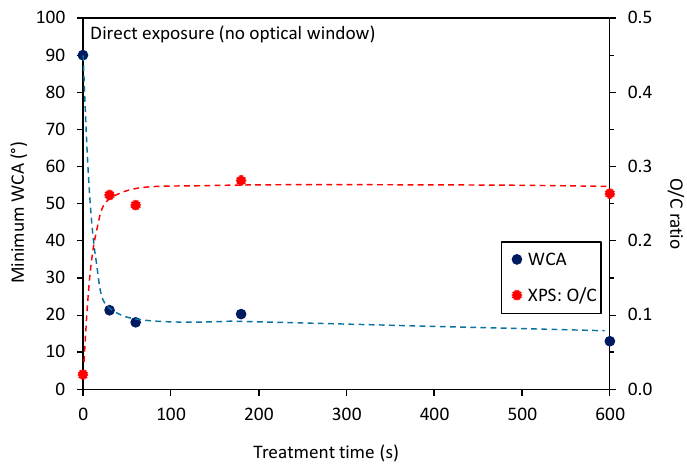
Figure 5. Variation of the minimum water contact angle and O / C ratio versus treatment time for the case of direct exposure of samples to plasma jet (no optical covering).